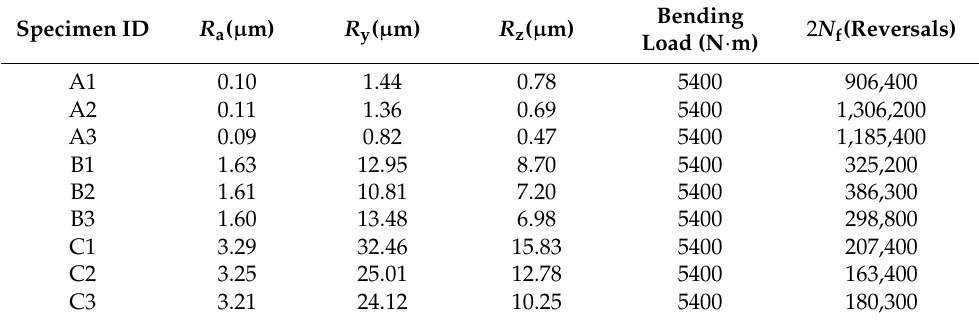
Table 4. Bending fatigue test results of stepped shafts.